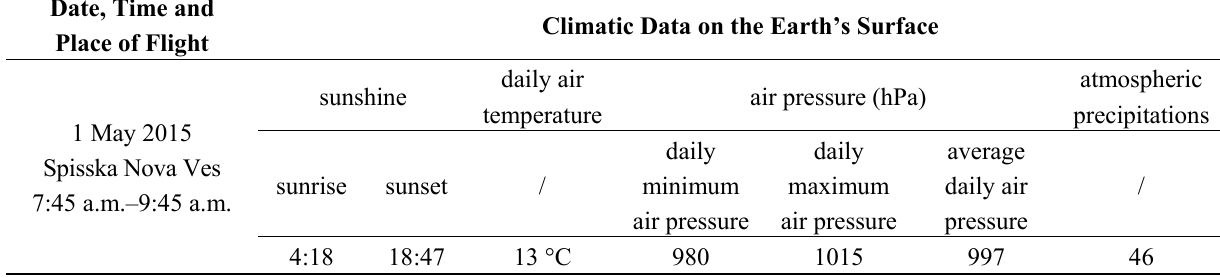
Table 1. Climatic data observed on the Earth’s surface before the start of the stratospheric flight. Date, Time